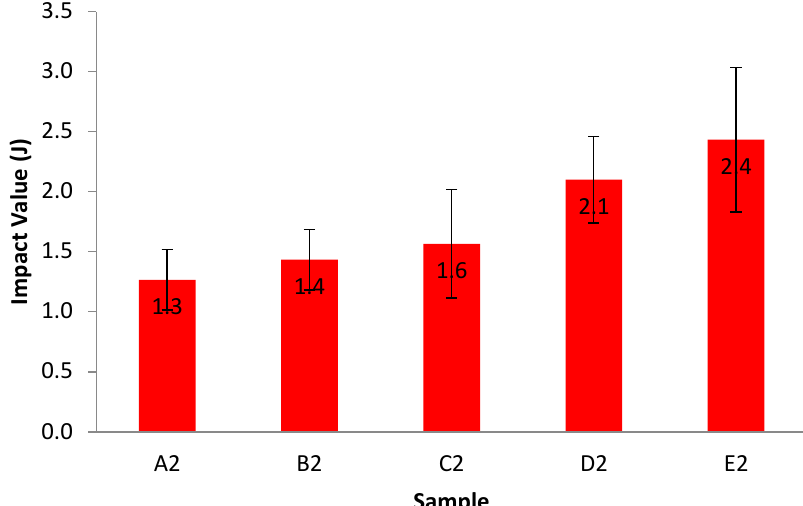
Figure 9. The results of impact testing on natural composite materials reinforced with sago midrib fiber, with percentage variations in the resin – catalyst matrix: (A 2 ) 99.5%:0.5; (B 2 ) 99%:1%; ( C 2 ) 98.5%:1.5%; (D 2 ) 98%:2%; (E 2 ) 97.5%:2.5%.